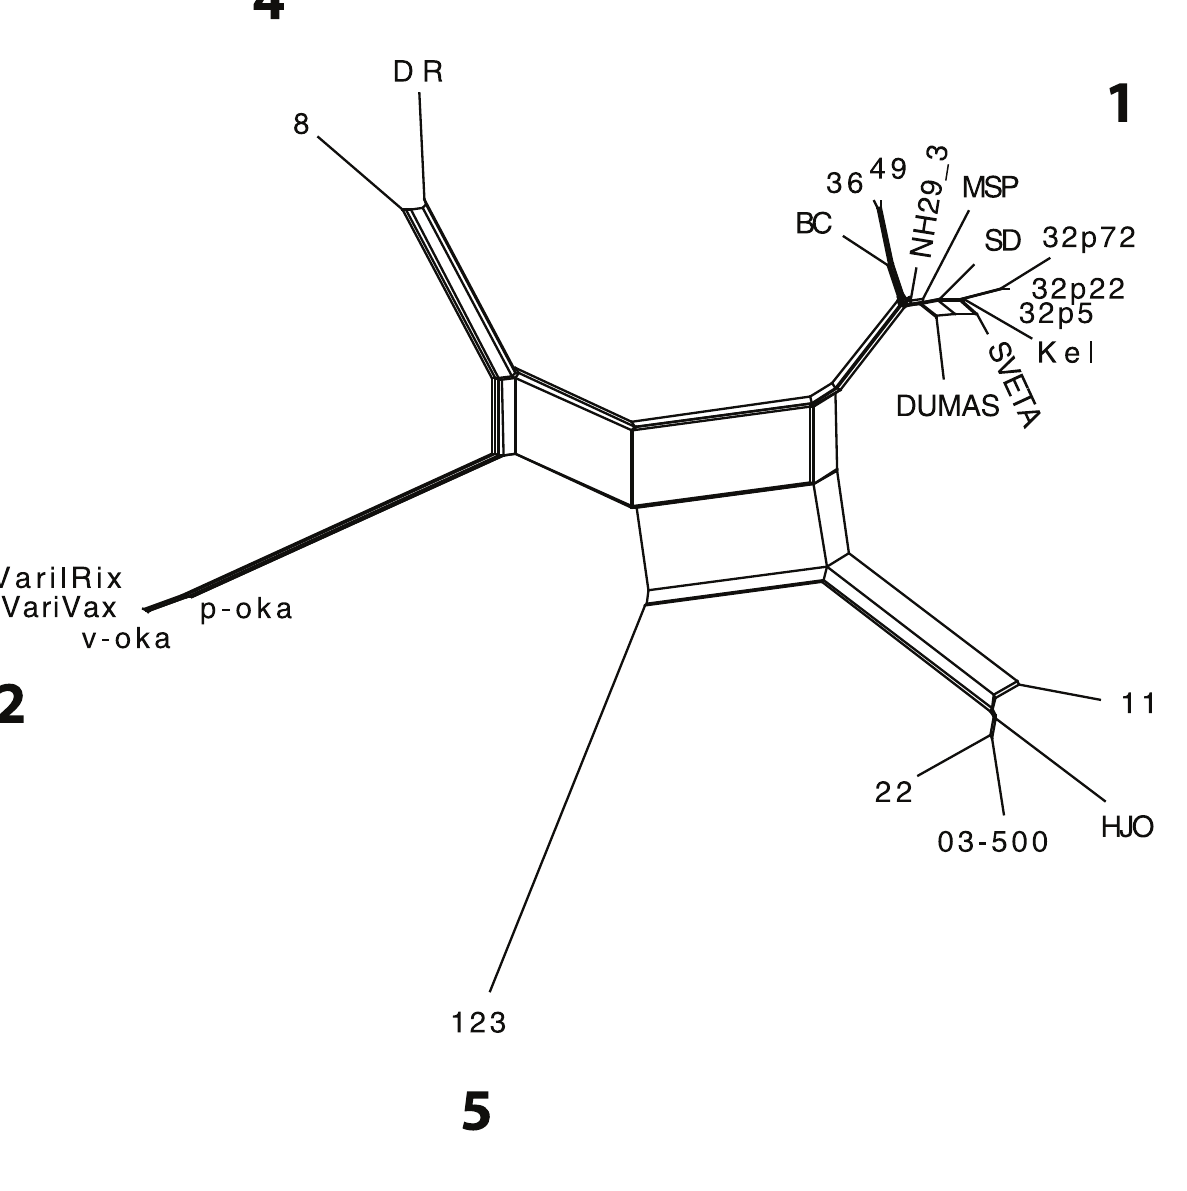
Figure 4. VZV phylogeny. Phylogenetic network (splits network) of available complete genome VZV sequences. The strains are divided into clades 1 to 5, and the deep lineage reticulate topology is caused by a few ancient recombination events described previously. The network also presents a reticulate pattern within clade 1 caused by a putative recent recombination event involving strain SVETA.